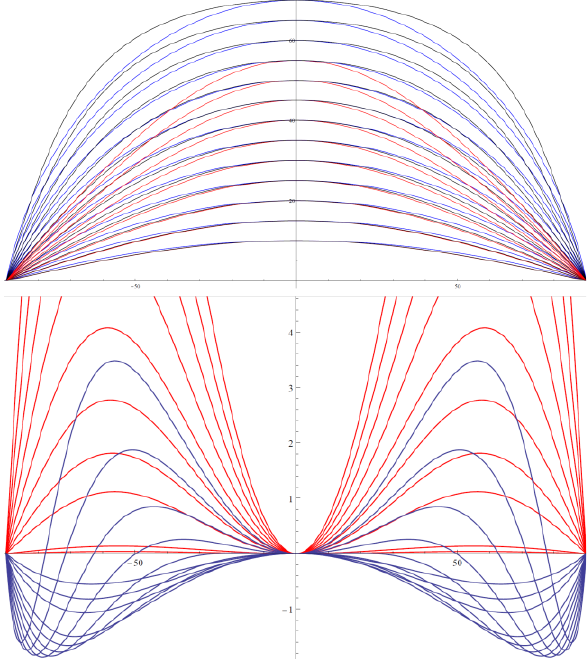
Figure 8 | Top: Plot of horizontals (black) with 𝜑 0 = 10 ∘ to 𝜑 0 = 70 ∘ in 5º increments, and of sinusoidal (red) and circular (blue) approximations. Sinusoids omitted for 𝜑 0 > 55 ∘ . Bottom: Plot of the errors of the approximations above. The error of the sinusoids (red) is always positive, with a single maximum near the 60º mark. For circles (blue), it starts negative for small 𝜑 0 , with a single minimum, and then develops two extrema with both negative and positive errors. The minimum stays above the -2º mark and maximum grows with 𝜑 0 , its latitude shifting nearer to ±90 ∘ .